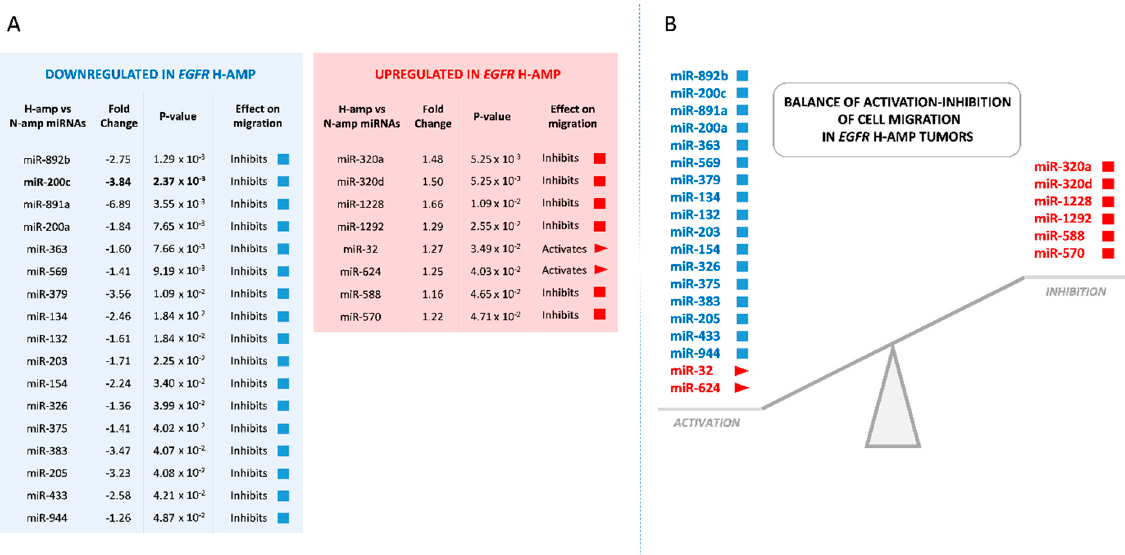
Figure 1. MiRNAs implied in cell migration that are differentially expressed in EGFR H-amp and N-amp tumors. ( A ) MiRNAs downregulated and upregulated in H-amp with respect to N-amp, ordered by statistical significance ( p ≤ 0.05 ). ( B ) Scheme showing the balance between miRNAs whose expression would activate migration and miRNAs whose expression would inhibit migration in H-amp samples.